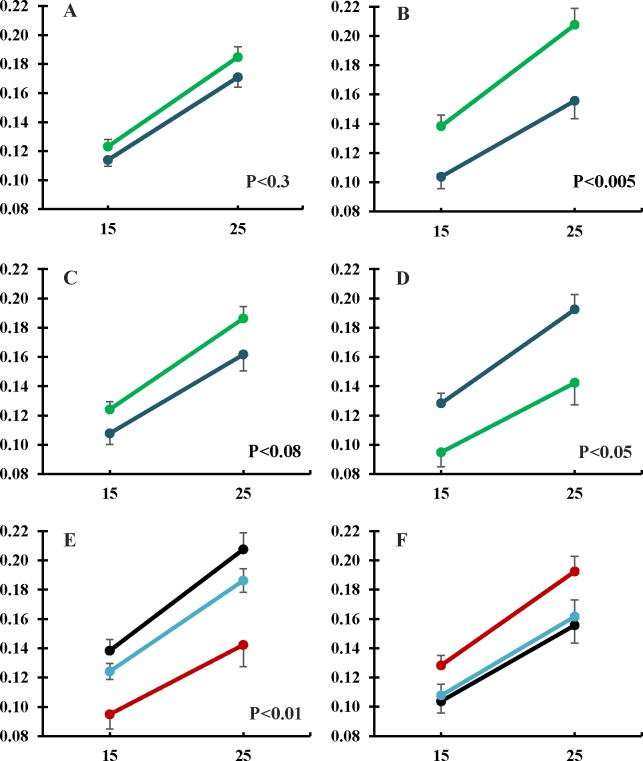
Changes in ADWG (Kg/day ± S.E.M.) of piglets throughout lactation period.The panel A represents total differences between groups of treatment. Panels B, C and D represent between-treatments differences considering litter size (2–6, 7–8 and 9–10 piglets, respectively). Panels E and F represent within-treatment differences considering litter size in control and treated groups, respectively. Dark blue: Hydroxytyrosol group. Green: Control group. Red: 9–10 piglets/litter. Light blue: 8–7 piglets/litter. Black: 2–6 piglets/litter.